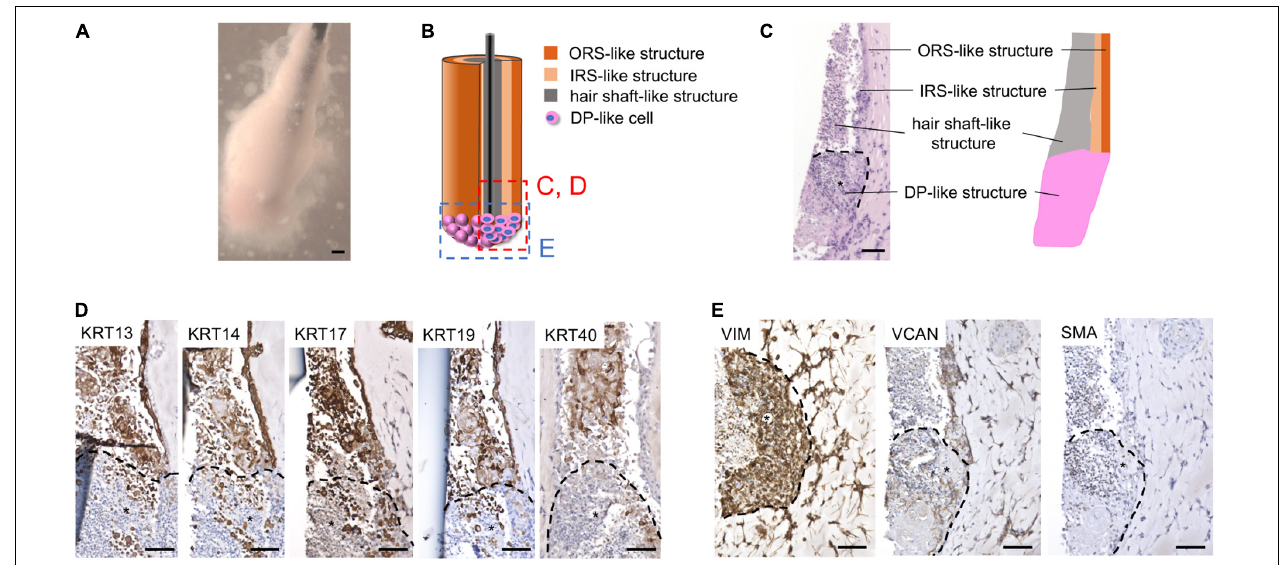
FIGURE 5 | KC-iDP constructs reproduced architectural/biochemical characteristics and gene expression profile of KC-DP constructs. (A) Morphology of KC-iDP constructs. Scale bar: 200 µ m. (B) The schema illustrating the intratissue structure of KC-iDP constructs. (C) Histological characteristics of KC-iDP constructs resembling those of KC-DP constructs (see Figure 2 ). *: iDP aggregates. Scale bar: 200 µ m. (D) Immunohistochemical analysis revealed that HF keratin distribution was almost indistinguishable between KC-DP and KC-iDP constructs (see Figure 2 ). KRT40-positive cells rearranged in the center of the main body mimicking the hair shaft without being splitted by a nylon fiber (the rightmost panel). *: iDP aggregates. Scale bar: 200 µ m. (E) Immunoreactivities for mesenchymal markers in KC-iDP constructs. *: iDP aggregates. Scale bar: 200 µ m; DP, dermal papilla; KC, keratinocyte; KRT, keratin; HF, hair follicle; iDP, human induced pluripotent cell-derived dermal papilla substituting cell aggregate; IRS, inner root sheath; ORS, outer root sheath; SMA, smooth muscle actin; VCAN, versican; VIM,